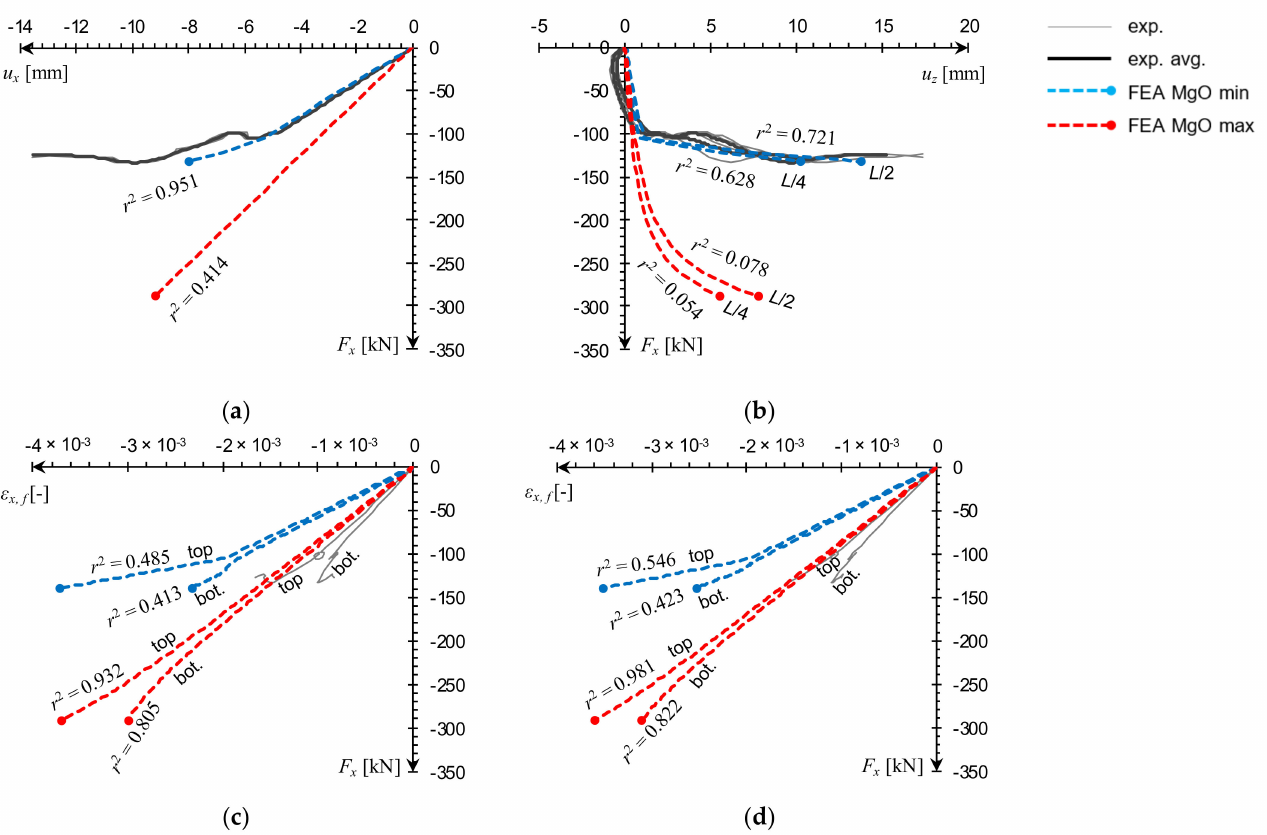
Figure 17. Comparison of natural-scale e0 panel compression test curves obtained from FEA against experimental